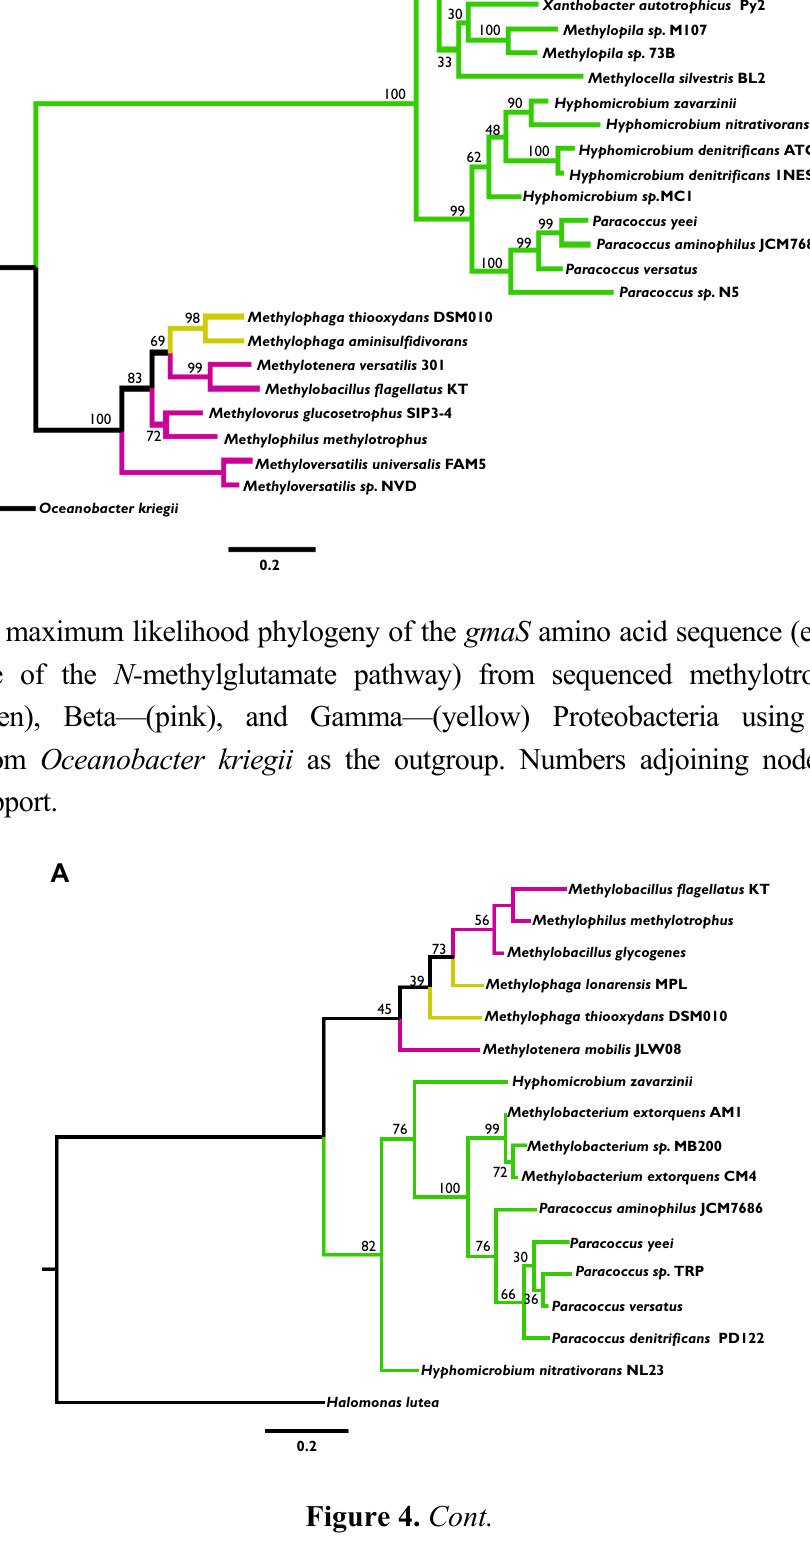
Methylobacterium extorquens DM4 Methylobacterium extorquens CM4 Methylobacterium extorquens PA1 Methylobacterium extorquens DSM13060